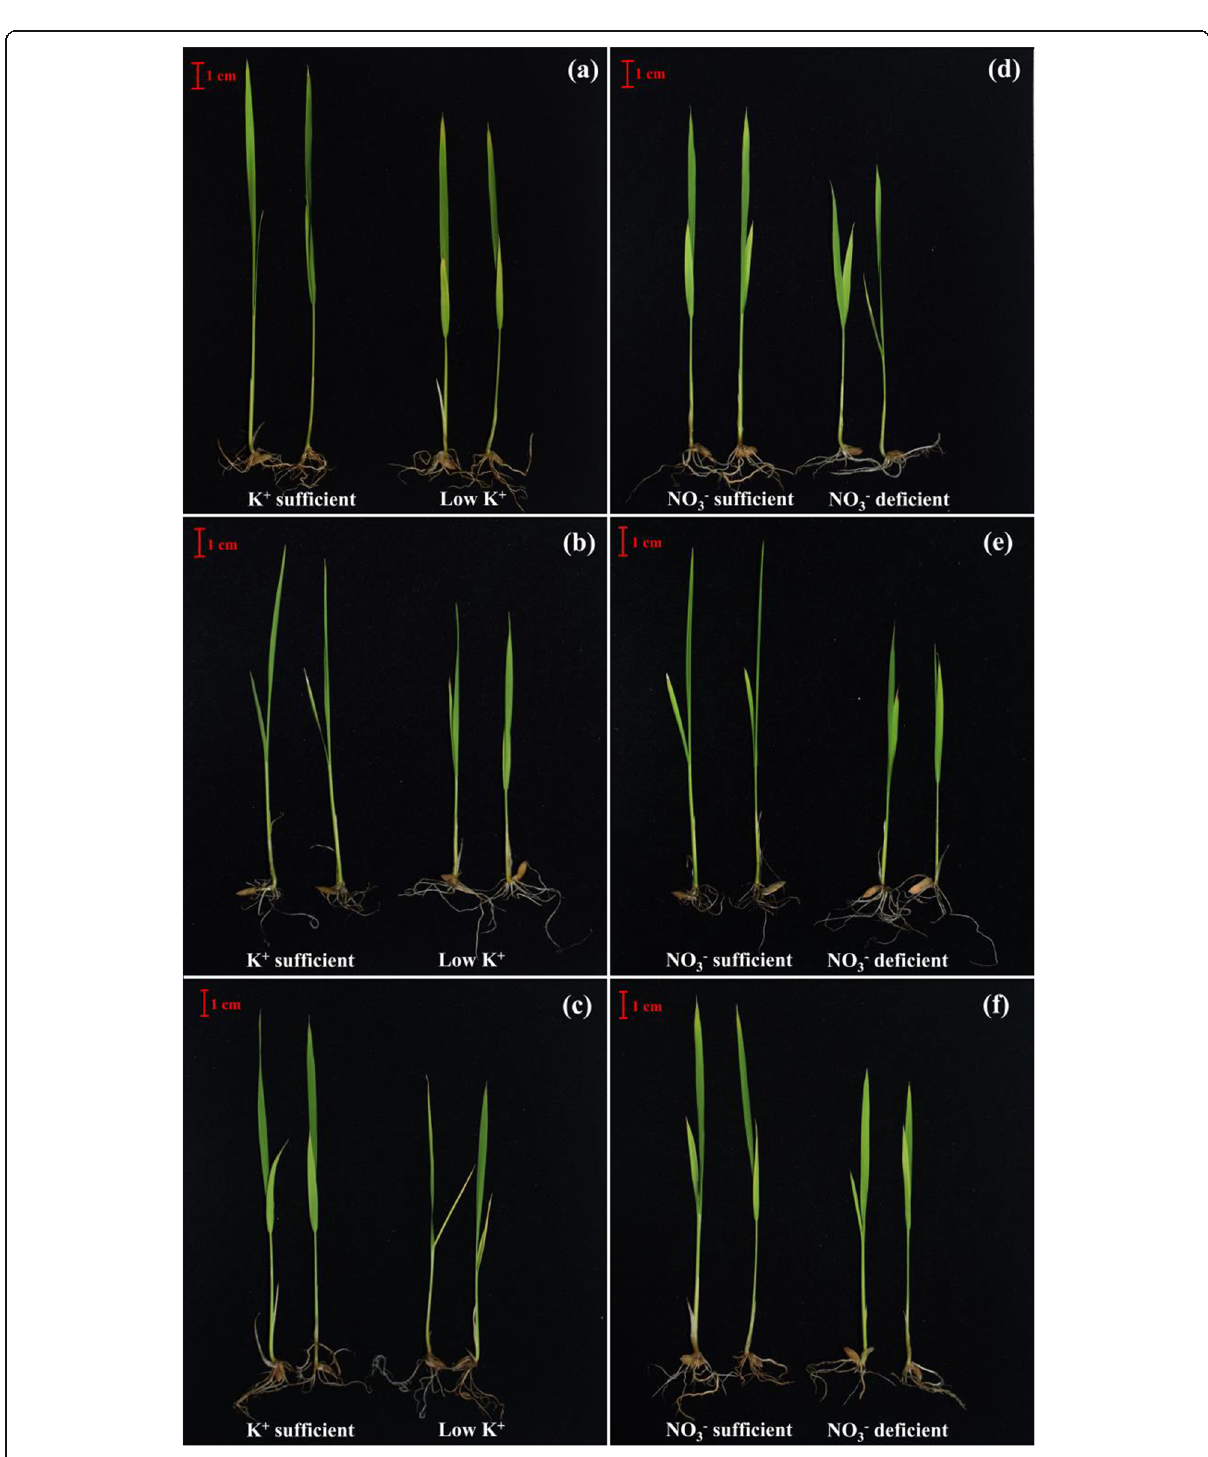
Fig. 5 Morphology of the plants grown into K + sufficient/low K + medium in BRRI dhan56 ( a ), BRRI dhan48 ( b ), BRRI dhan71 ( c ), and NO 3 −